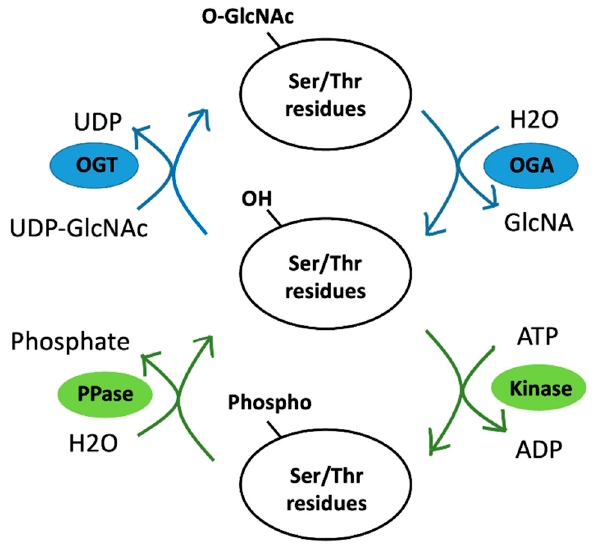
Figure 3. PTM crosstalk between O -GlcNAcylation and phosphorylation. Phosphorylation occurs when protein kinase attaches a phosphate group from ATP to the substrate; in contrast, PPase removes a phosphate group from a phosphoprotein. Similarly, OGT adds O -GlcNAc from UDP-GlcNAc to the substrates for O -GlcNAcylation. Conversely, OGA removes O -GlcNAc. These two processes are both reversible. Because phosphorylation and O -GlcNAcylation can compete for serine and threonine residues, PTM crosstalk occurs [83]. Abbreviations: O -GlcNAc, O -linked β - N -acetylglucosamine; OGT, O -GlcNAc transferase; OGA, O -GlcNAcase; Ser, serine; Thr, threonine; ATP, adenosine triphosphate; ADT, adenosine diphosphate; UPD, uridine diphosphate; PPase, protein